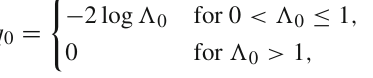
Fig. 10 Profile likelihood plots of the PM parameters from a fit to T a and T R results histograms, corresponding to input m X = 700GeV, (cid:3) / m = 5% and set 1 parameter values. The fit is performed over the X X